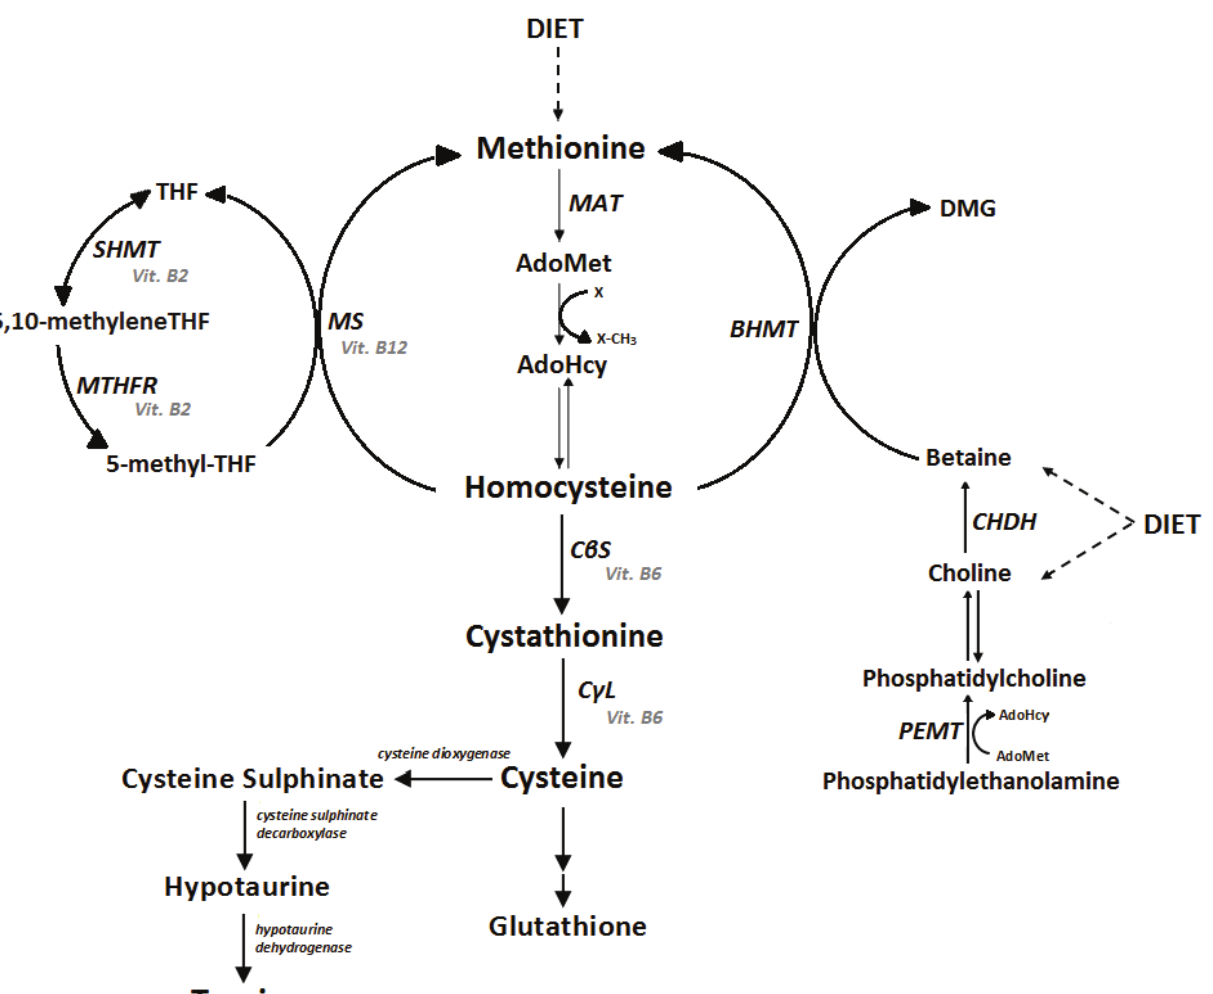
Figure 1. Metabolism of sulfur amino acids. MAT, methionine adenosyltransferase; AdoMet, S -adenosylmethionine; AdoHcy, S -adenosylhomocysteine; X, methyl acceptor; CβS , cystathionine β - synthase; CγL , cystathionine γ -lyase; MS, methionine